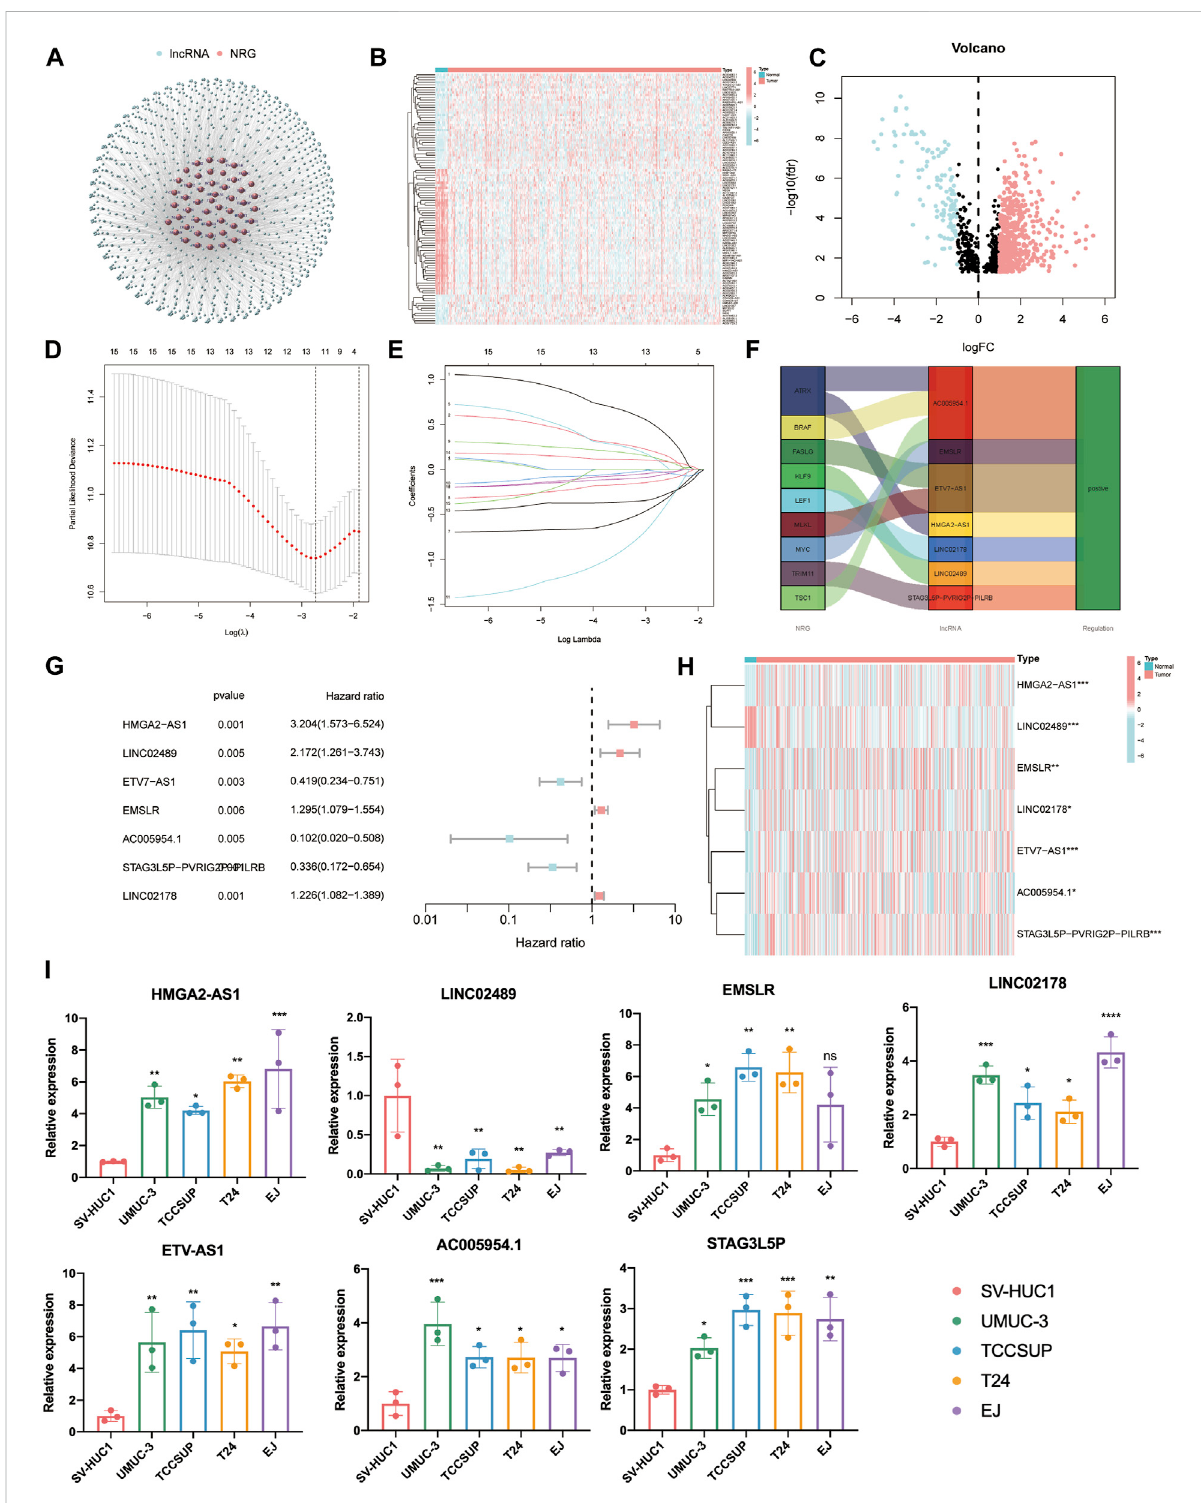
FIGURE 2 Identi fi cation of prognostic necroptosis-related lncRNAs (NLRs) in muscle-invasive bladder cancer (MIBC). (A) The network fi gure of necroptosis- relatedgenes(NRGs)andNLRs(correlationcoef fi cient > 0.4and p < 0.001). (B) TheheatmapofdifferentNLRsbetweentumorandnormalsamples. (C) The volcanoplotof689differentiallyexpressedNLRs. (D) Thecross-validationforvariableselectionintheleastabsoluteshrinkageandselectionoperator(LASSO) model. (E) The LASSO coef fi cient pro fi le of 12 NLRs. (F) The Sankey diagram of the relationship between necroptosis-related genes (NRGs) and NLRs. (G,H) The forest plot and heat map of determined prognostic NLRs that executed by multivariate Cox proportional hazard regression analysis. (I) The qRT- PCR results of seven prognostic NLRs in bladder cancer cells. * p < 0.05, ** p < 0.01, *** p < 0.001, **** p < 0.0001. ns, not signi fi